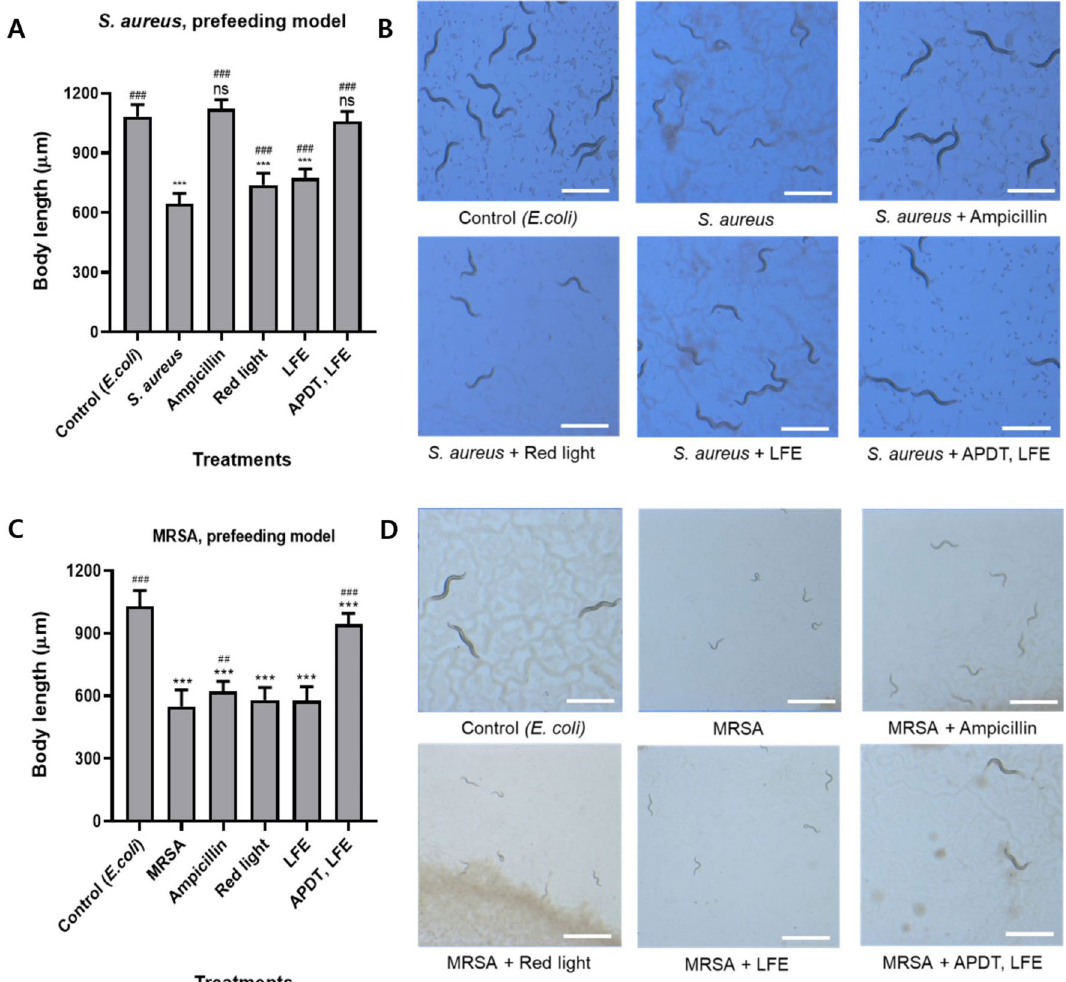
Fig. 5 Effect of APDT‑LFE on the growth of C. elegans in the prefeeding model. S. aureus KCTC3881 or MRSA was pretreated with APDT using LFE (20 µg/mL; 30 min incubation) and red light 120 W/m 2 for 15 min. The treatment with ampicillin (100 µg/mL) served as the positive control. Synchronized eggs were fed with E. coli OP50 as vehicle control, or treated MRSA or S. aureus with APDT or ampicillin. The body length A , C and the microscopic images of the worms B , D were evaluated four days after the egg state. White scale bar 1 mm. The data are representative of = three independent experiments. Analysis of variance test (n 20). ns indicates no statistical significance relative to the control group; significant = differences are expressed with *** for p < 0.001 relative to the vehicle control group; ## for p < 0.01, ### for p < 0.001 relative to the pathogen